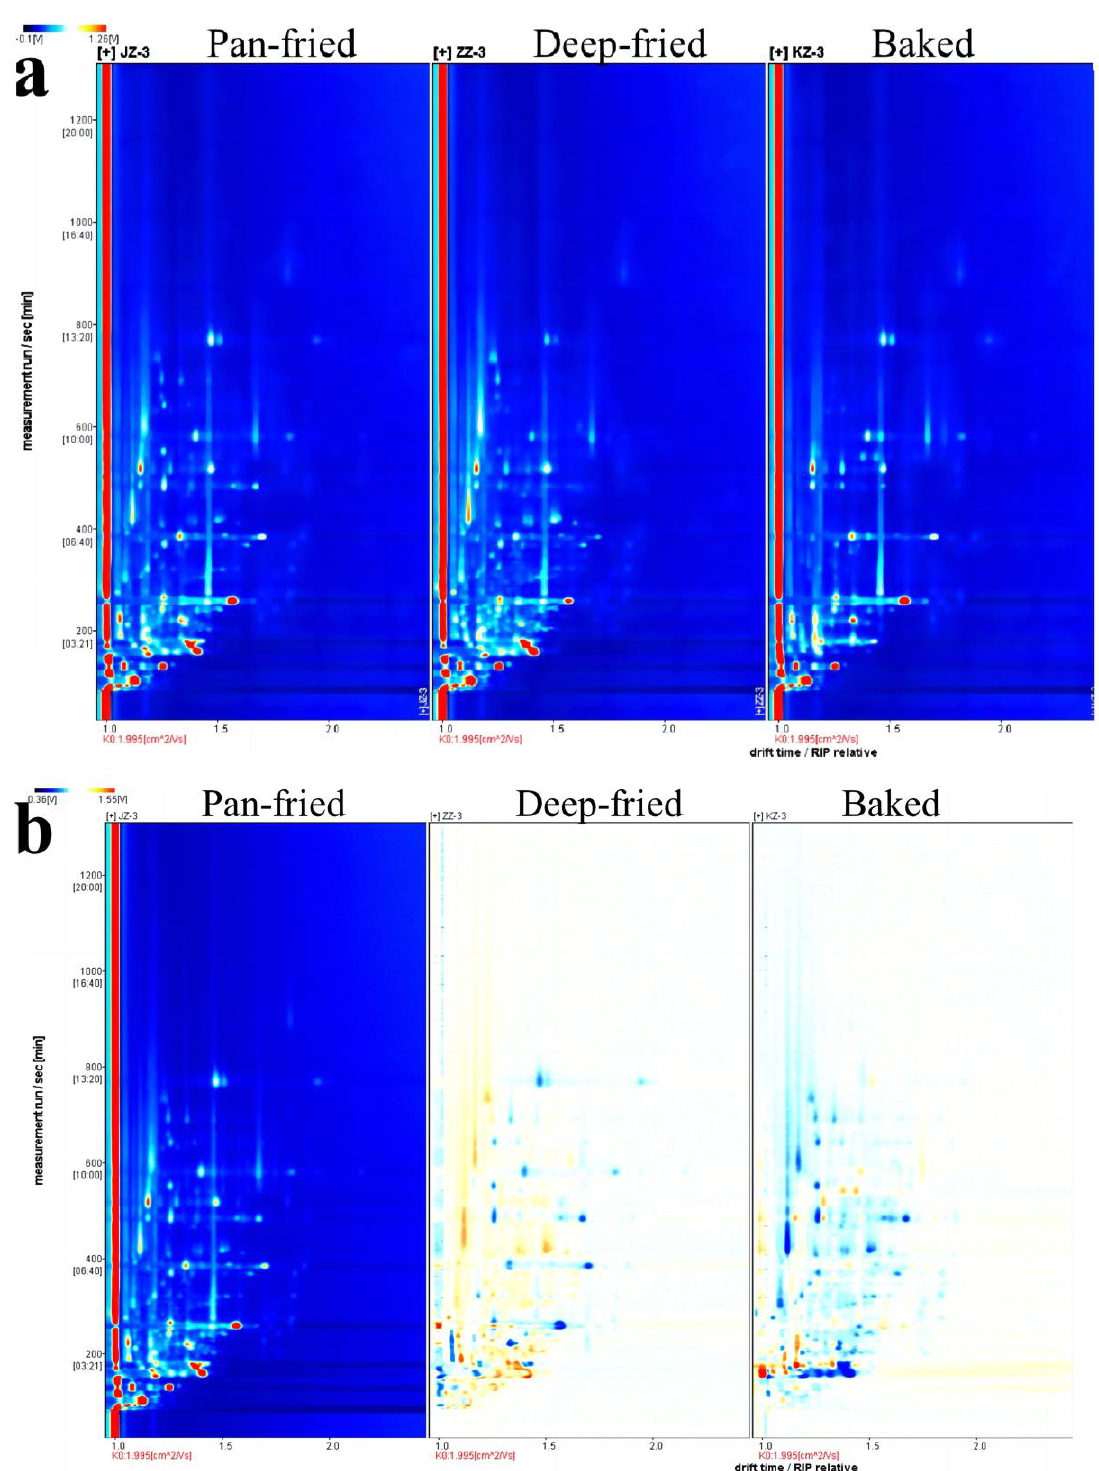
Figure 5. 2D topographic map of BTS meat processed by different high-temperature cooking methods. ( a ): ion mobility spectrogram; ( b ): comparison results under the spectral diagram of pan-fried sample was selected as the